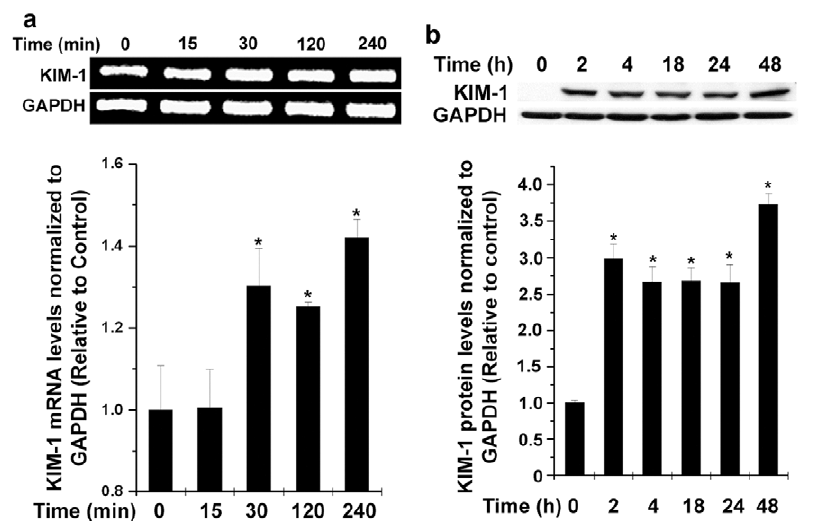
Figure 1. Human Kidney Epithelial Cells (HK-2) in culture, exposed to Sodium Oxalate showed increased KIM-1 mRNA and protein levels. ( a ) Oxalate was added to serum starved HK-2 cells and incubated for various time points. KIM-1 mRNA levels were estimated by Relative quantitative PCR and ( Top Panel ) representative gel image is shown. ( Lower Panel ) Quantification of mRNA levels was performed by band density analysis and represented as a relative intensity compared to control. Each data point represents mean + / 2 S.D. of two independent PCRs (* indicates p , 0.05 compared to control, n=2). ( b ) Total protein was extracted as in materials and methods. Western blot analysis was used to detect KIM-1 protein levels in the cells. Representative blots from two individual experiments are shown ( Top Panel ). Densitometric analysis was used to quantify the KIM-1 protein levels. Each data point represents mean + / 2 S.D. of two independent gels (*indicates p , 0.05 compared to control, n=2).